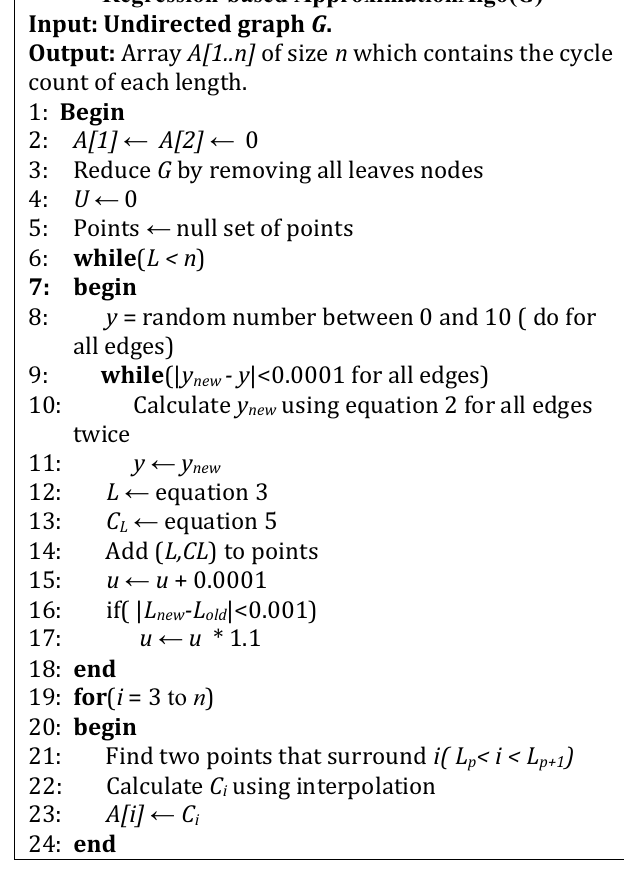
Figure 2. Pseudo code for Regression-based Approximation Algorithm